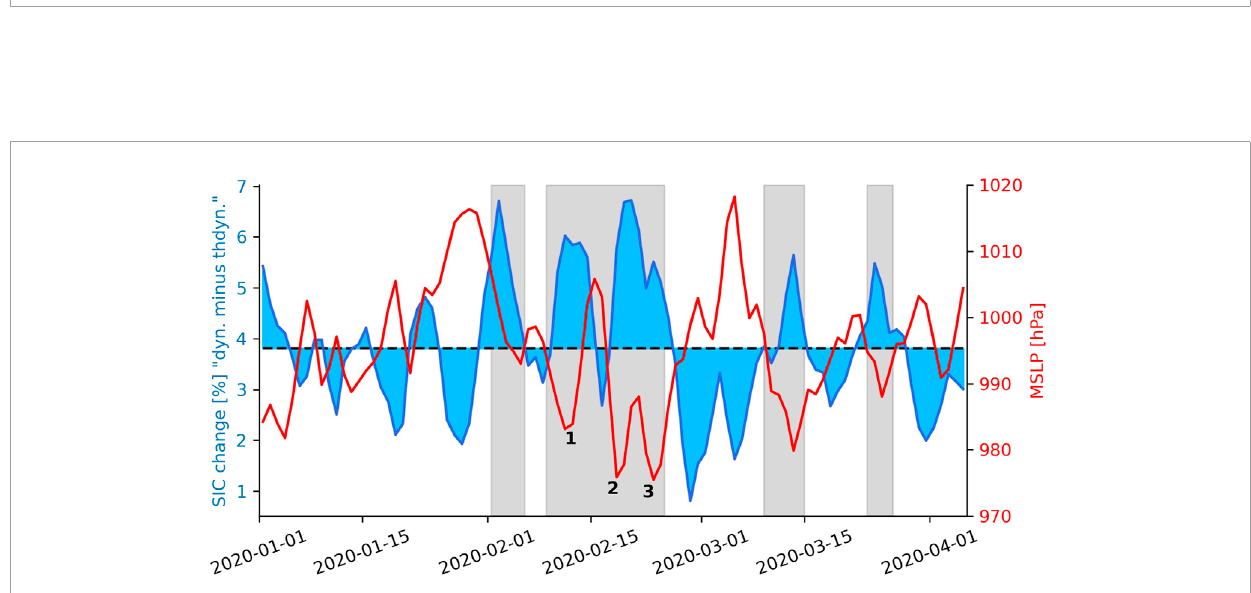
FIGURE 8 Temporally integrated thermodynamic SIT change (A–C) and difference between absolute values of temporally integrated dynamic and thermodynamic SIT change (D–F) during (20.2.—24.2.2020), shortly after (24.2.20—28.2.2020) and for a longer period after (24.2.—3.3.2020) cyclone 3 based on the HIRHAM–NAOSIM simulation. Pink lines indicate the position of the ice edge (15% SIC) at the start of the cyclone passage.